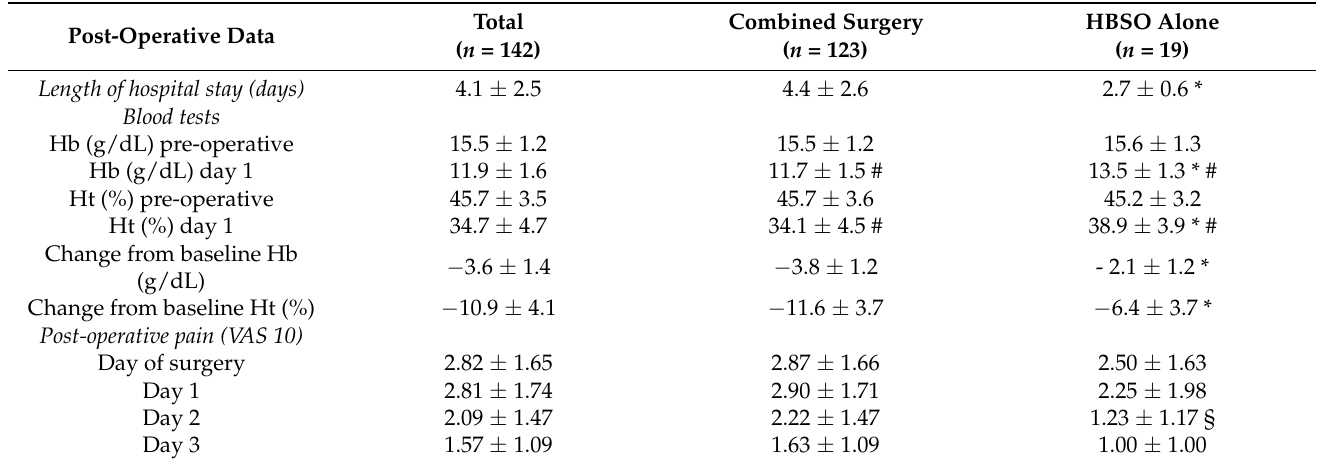
Table 3. Data on postoperative hospital stay, blood loss, and pain.